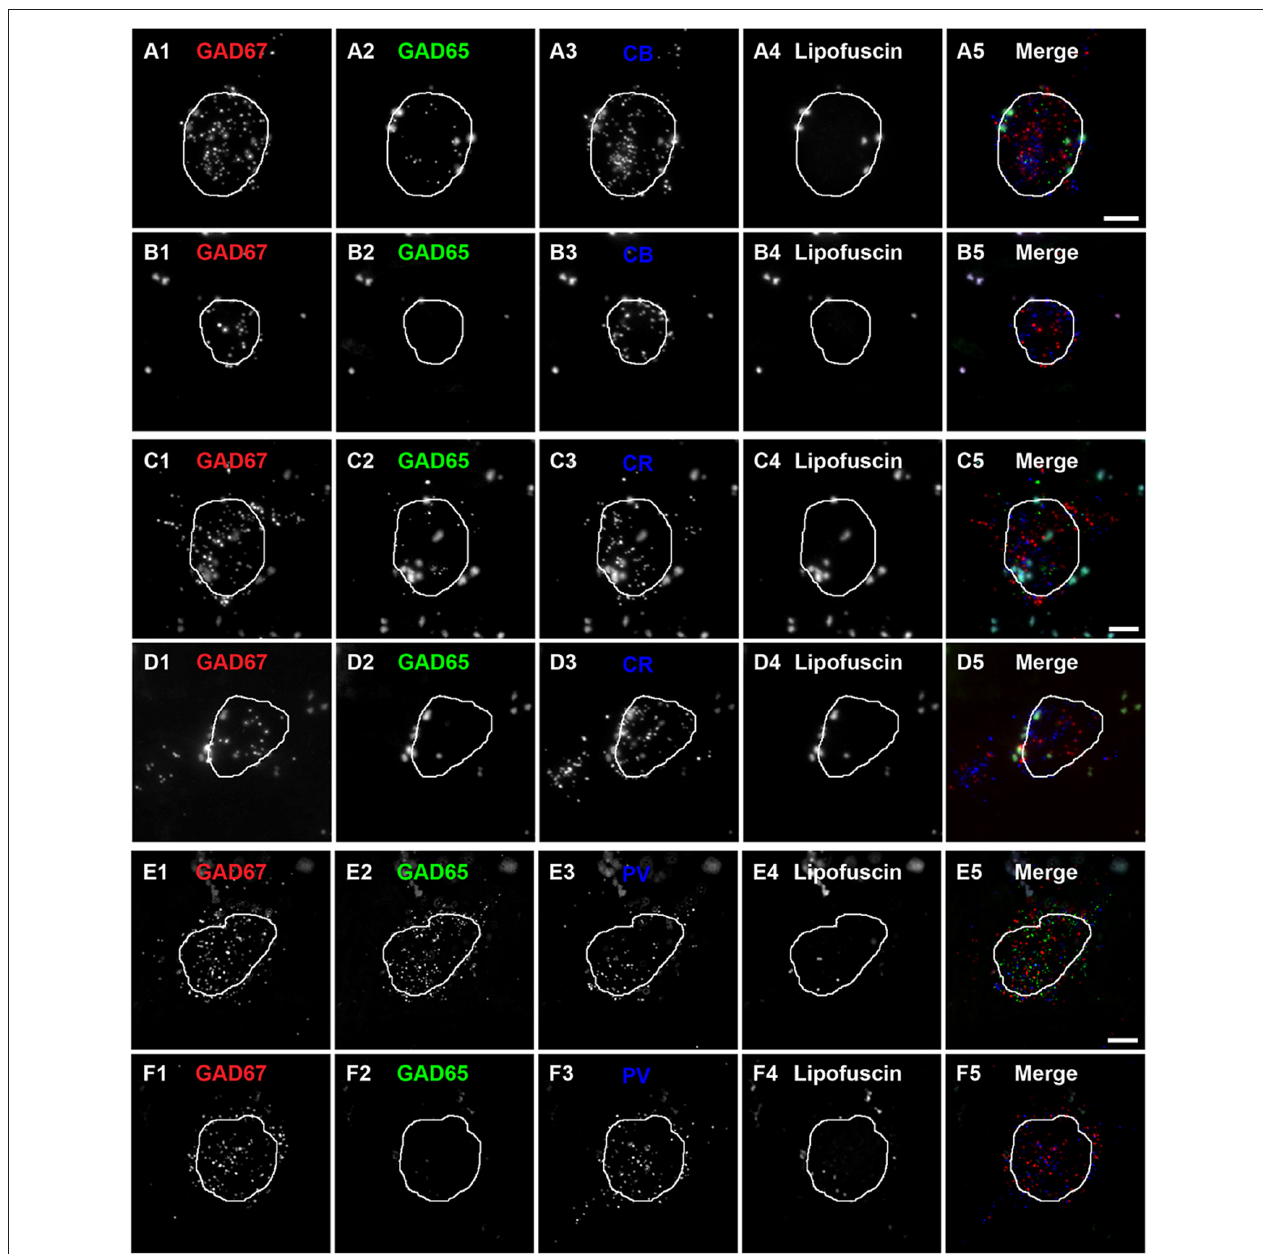
FIGURE 2 | Subtypes of CB, CR and PV neurons are distinguishable by the expression of GAD65 mRNA in human PFC. (A,B) Single plane image of a PFC tissue section labeled for CB, GAD65 and GAD67 mRNAs. (A5) and (B5) are merged images of (A1–A3) and (B1–B3) , respectively. Lipofuscin autofluorescence is shown in (A4,B4) . (C,D) Single plane image of a PFC tissue section labeled for CR, GAD65 and GAD67 mRNAs. (C5) and (D5) are merged images of (C1–C3) and (D1–D3) , respectively. Lipofuscin autofluorescence is shown in (C4,D4) . (E,F) Single plane image of a PFC tissue section labeled for PV, GAD65 and GAD67 mRNAs. (E5) and (F5) are merged images of (E1–E3) and (F1–F3) , respectively. Lipofuscin autofluorescence is shown in (E4,F4) . In all images, the outline of the nucleus, which was visualized using DAPI, is shown. Scale bars = 5 µ m.